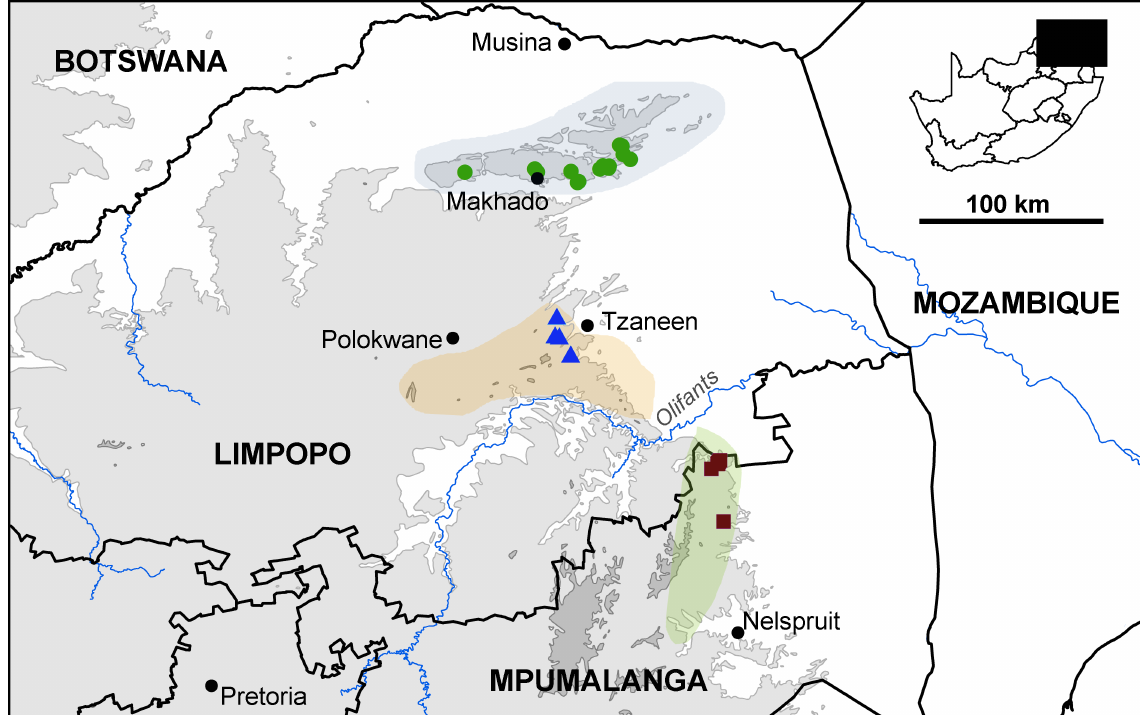
Fig. 8. Map showing the distribution of new urocyclid species in relation to centres of plant endemism (Van Wyk & Smith 2001). Green circles = Ptilototheca soutpansbergensis gen. et sp. nov.; blue triangles = Sheldonia wolkbergensis sp. nov.; maroon squares = Sheldonia monsmaripi sp. nov.; pale blue = Soutpansberg Centre; pale orange = Wolkberg Centre (Serala Subcentre); pale green = Wolkberg Centre (Blyde Subcentre). Contours at 1000 and